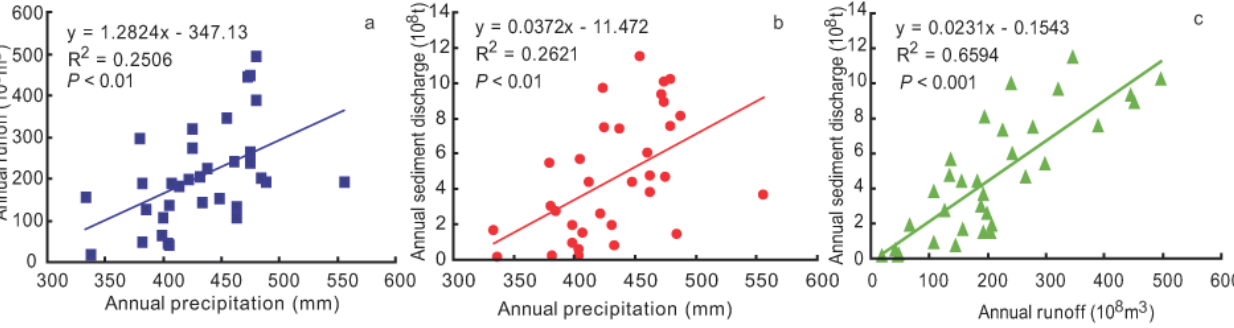
Fig. 3. Relationships of precipitation and runoff (a) , precipitation and sediment (b) and runoff and sediment discharge (c) in Yellow River Delta in